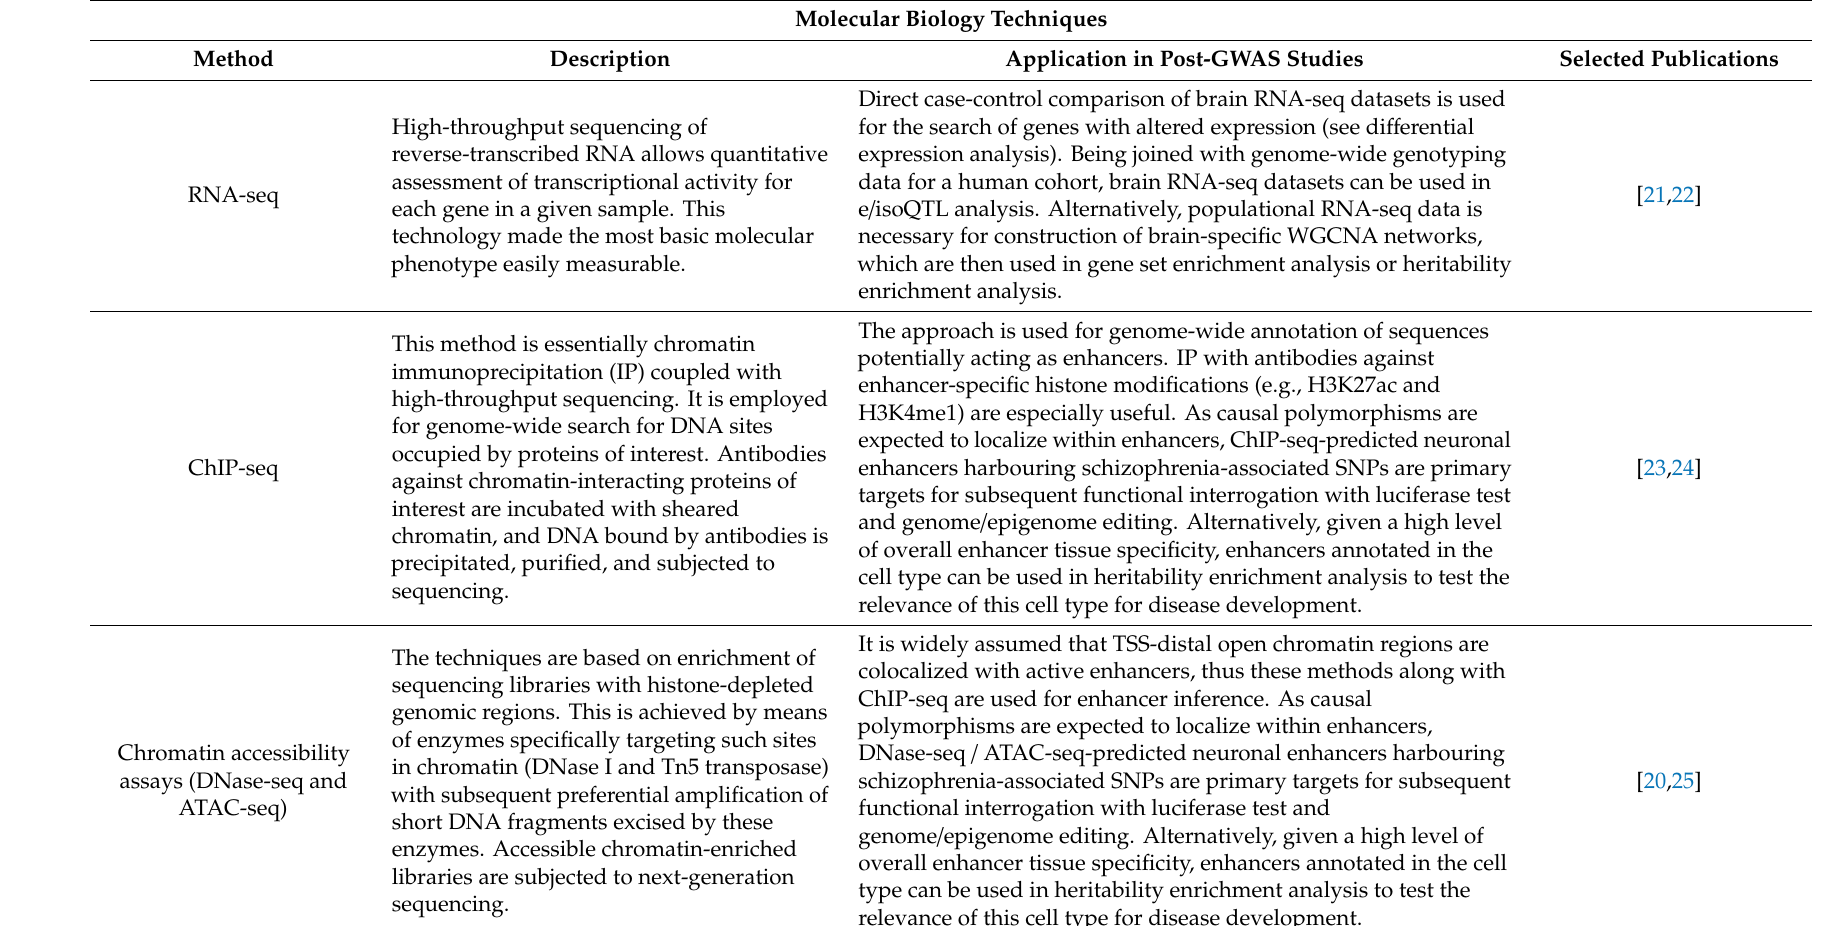
Table 1. Approaches most commonly used in schizophrenia post-GWAS